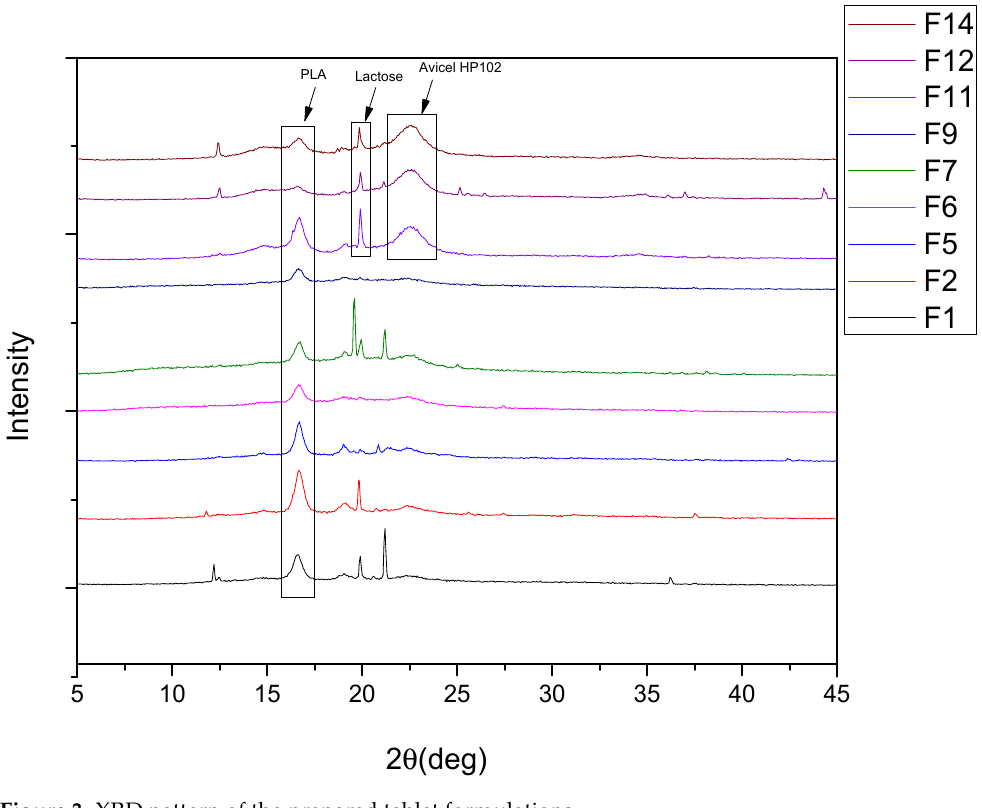
Figure 3. XRD pattern of the prepared tablet formulations.